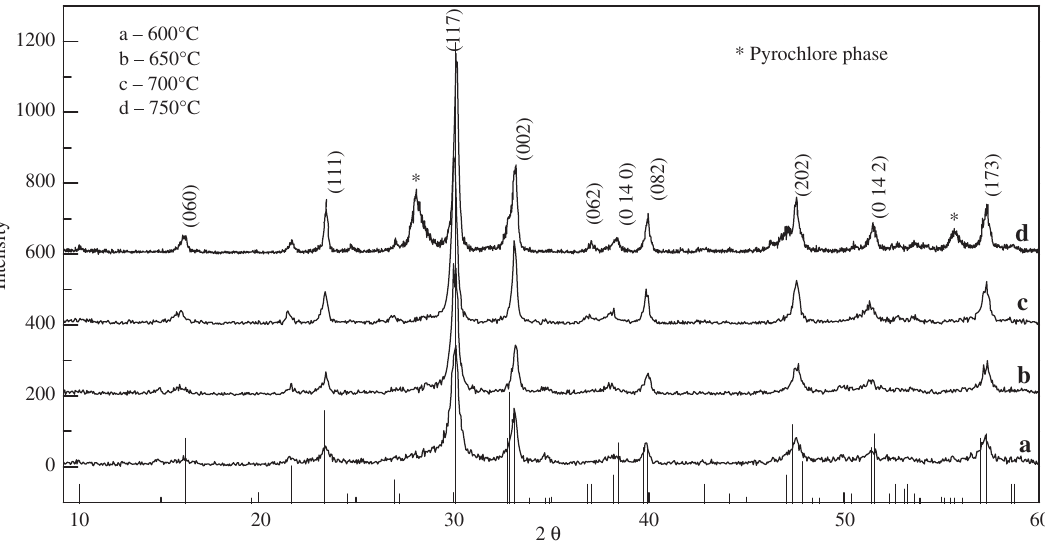
Figure 2 XRD of the powders annealed at different temperatures of 600 ° C, 650 ° C, 700 ° C and 750 ° C for BceT.